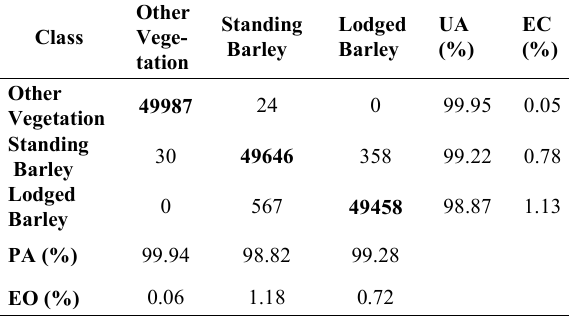
Table 3. Random Forests OOB confusion matrix with User's and Producer's Accuracies and Errors of Omission and Commission. The bold figures indicate correctly classified pixels for each